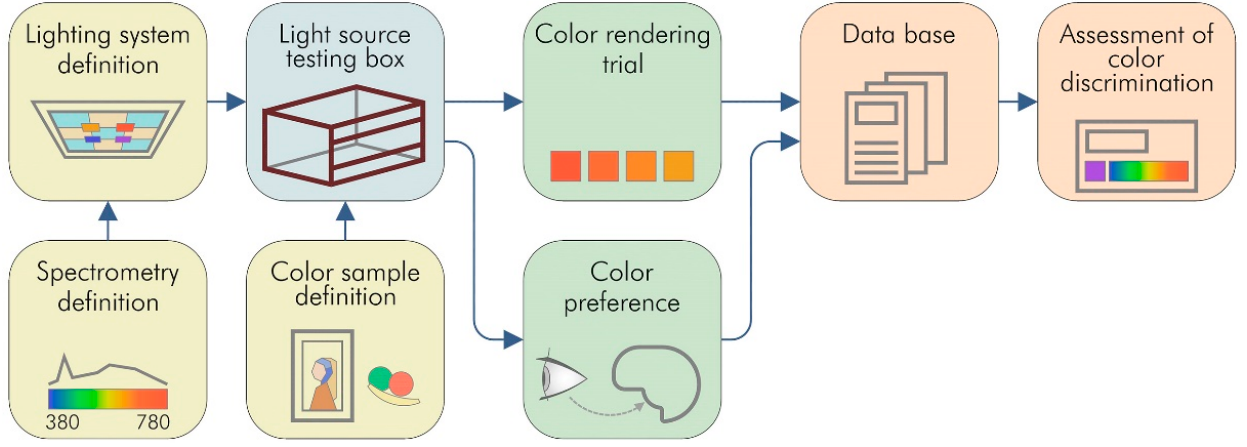
Figure 1. Flowchart of the proposed methodology.